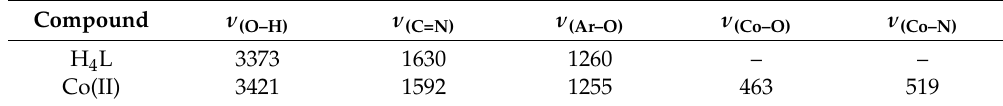
Table 4. Major IR bands for H 4 L and its Co(II) coordination compound(cm − 1